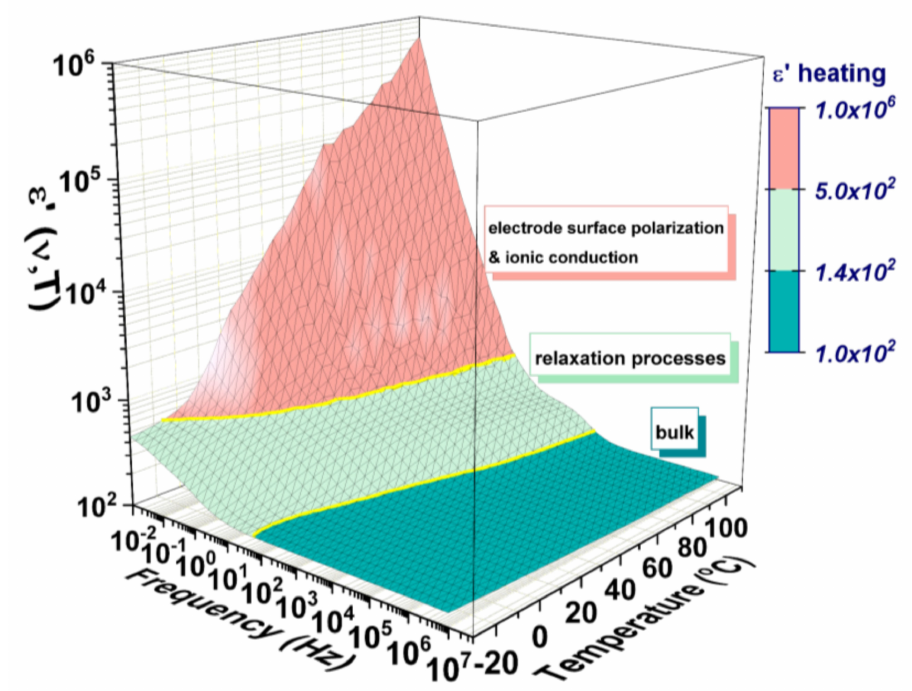
Figure 5. The real part of dielectric permittivity represented as a function of frequency and tempera- ture at heating (for cooling see Figure S1 in Supplementary